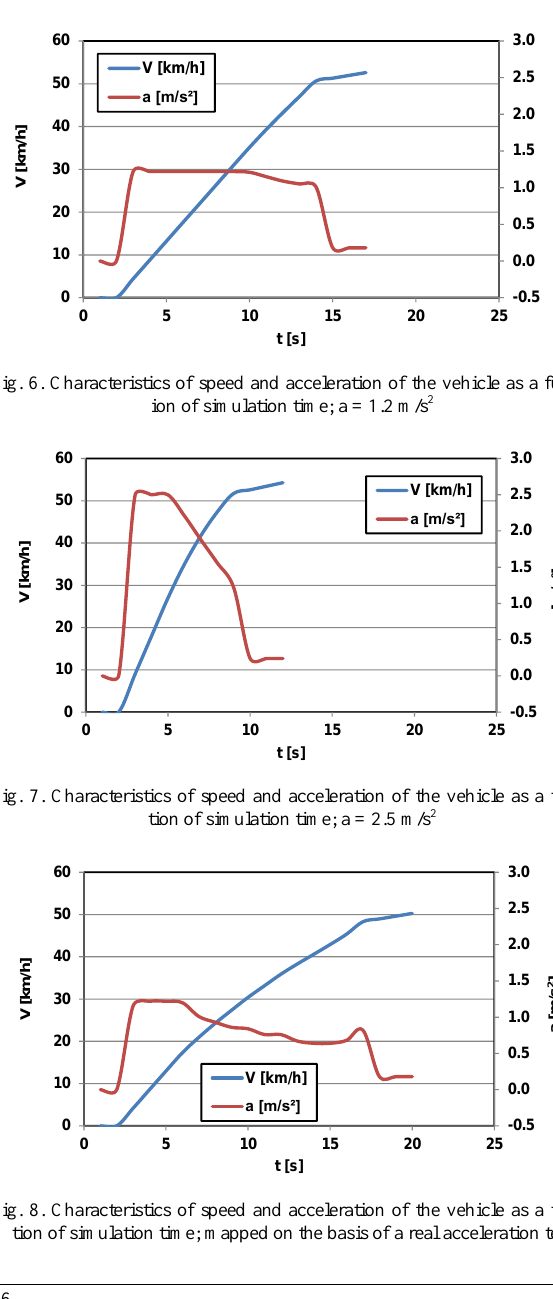
Fig. 5. Characteristics of speed and acceleration of the vehicle as a func- tion of simulation time; a = 1.0 m/s 2